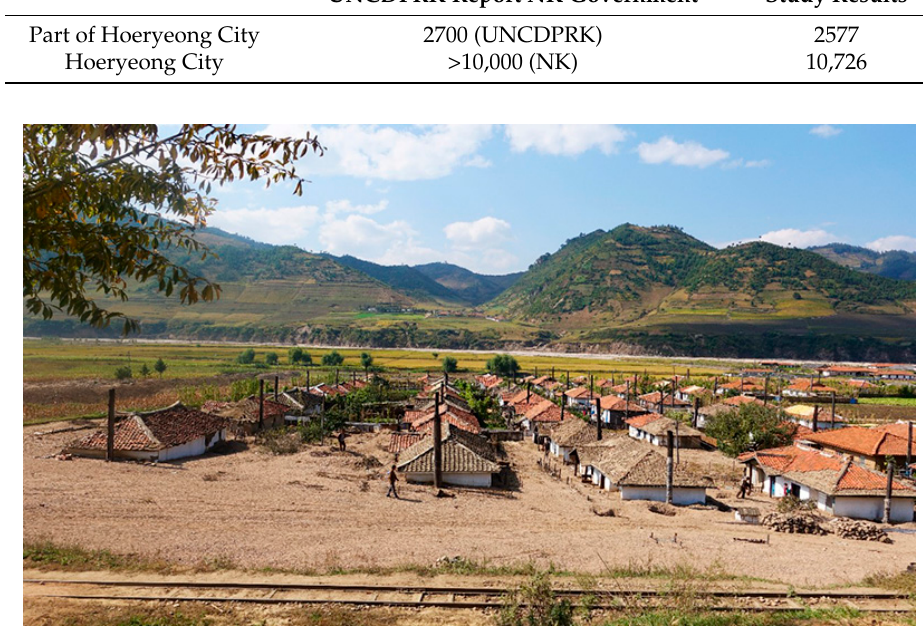
Figure 10. Flood-damaged residential houses in the study area (source: http://kp.one.un.org/content/unct/dprk/en/home/emergency-response/floods-2016.html).